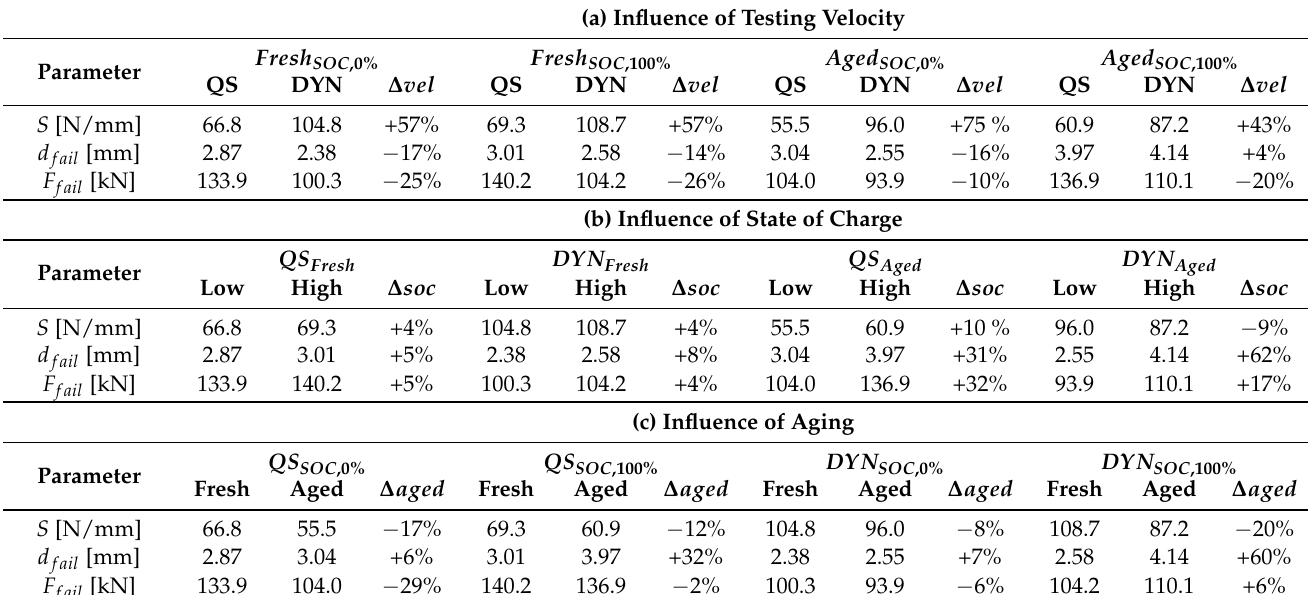
Table 2. Change of cell stiffness S , failure displacement d fail and failure force F fail and how these parameters are influenced by increasing the ( a ) testing velocity ( ∆ vel ), ( b ) the state of charge ( ∆ soc ) or ( c ) using an electrical aged cell compared to a fresh cell ( ∆ aged ). (a) Influence of Testing Velocity